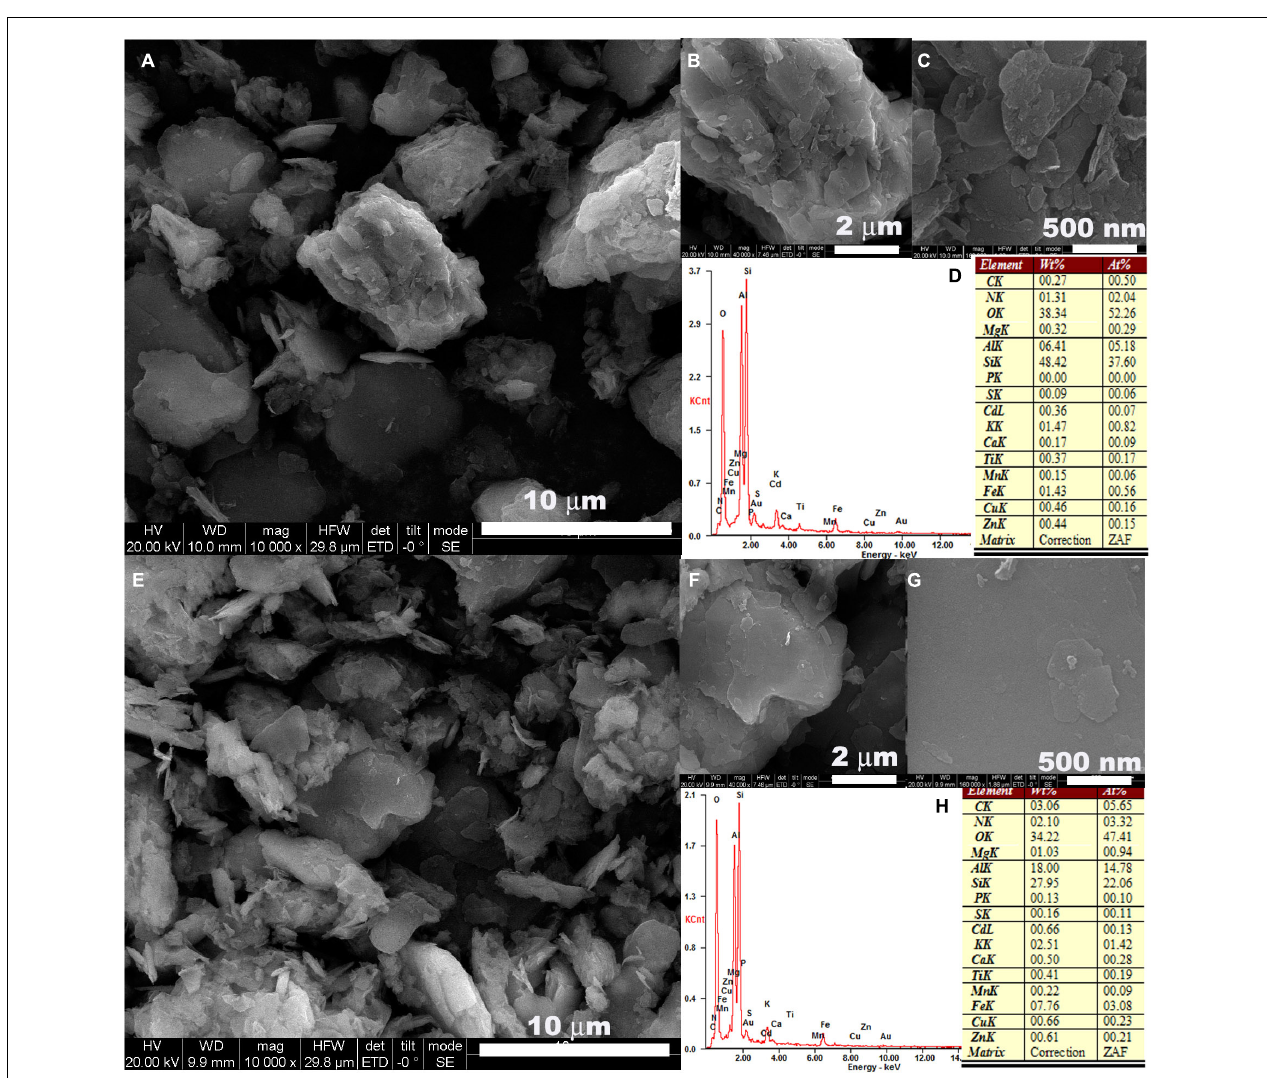
amendment, and its corresponding EDS result (D,H) (cid:104)